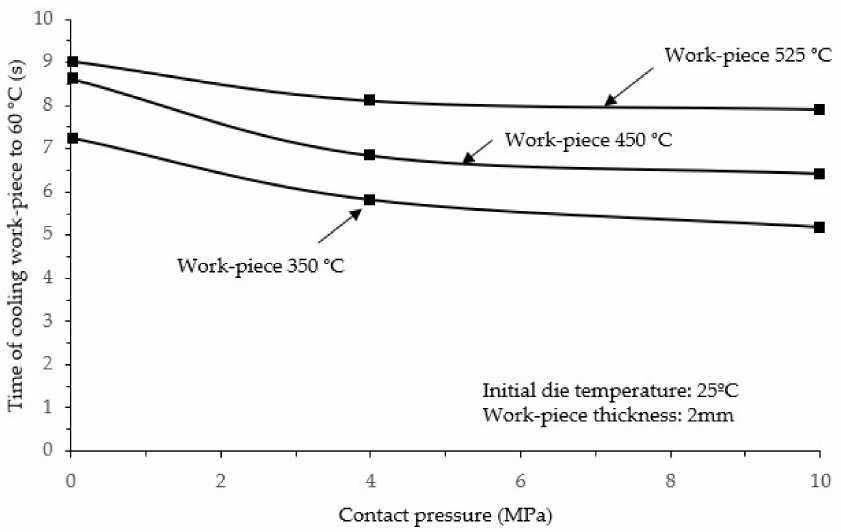
Figure 8. Effects of in-die quenching pressure on the in-die quenching efficiency. The initial die temperature was 25 ◦ C. The work-piece thickness was 2